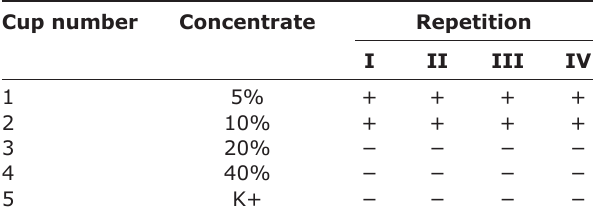
Table-2: Minimum bactericidal concentration in Meniran and positive control antibiotics. Cup